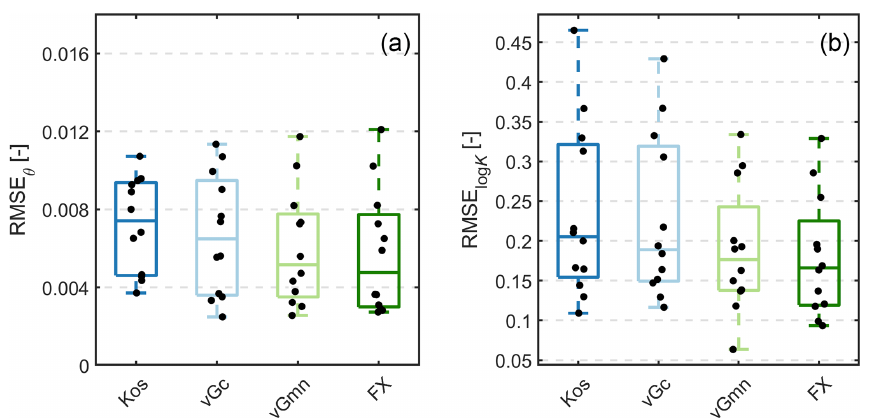
Figure 3. Distributions of RMSE θ and RMSE log K of the fitted retention and conductivity models for the 12 data sets. Black dots indicate single realizations.